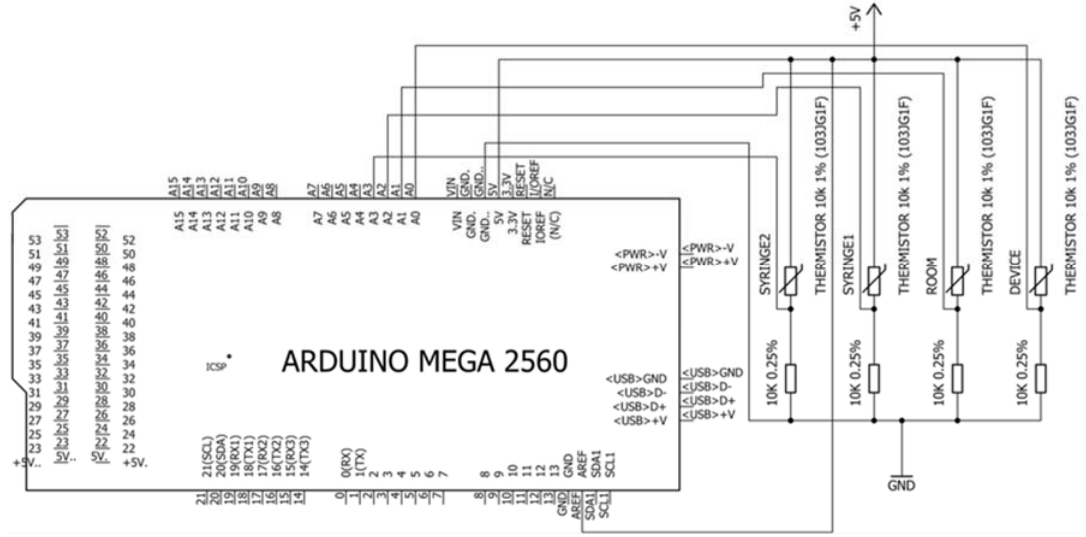
Figure A4. Electronic schematic of the circuit used in this study to collect thermistor data.